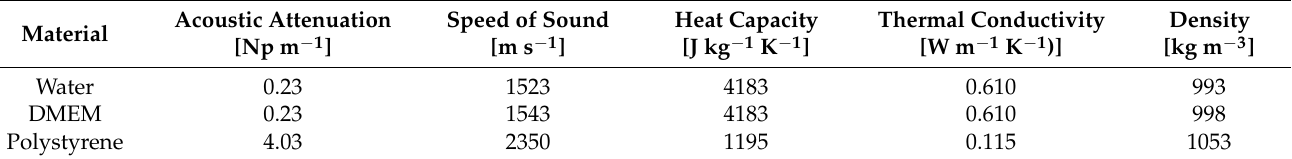
Table 1. Acoustic and thermal properties of materials used in simulations